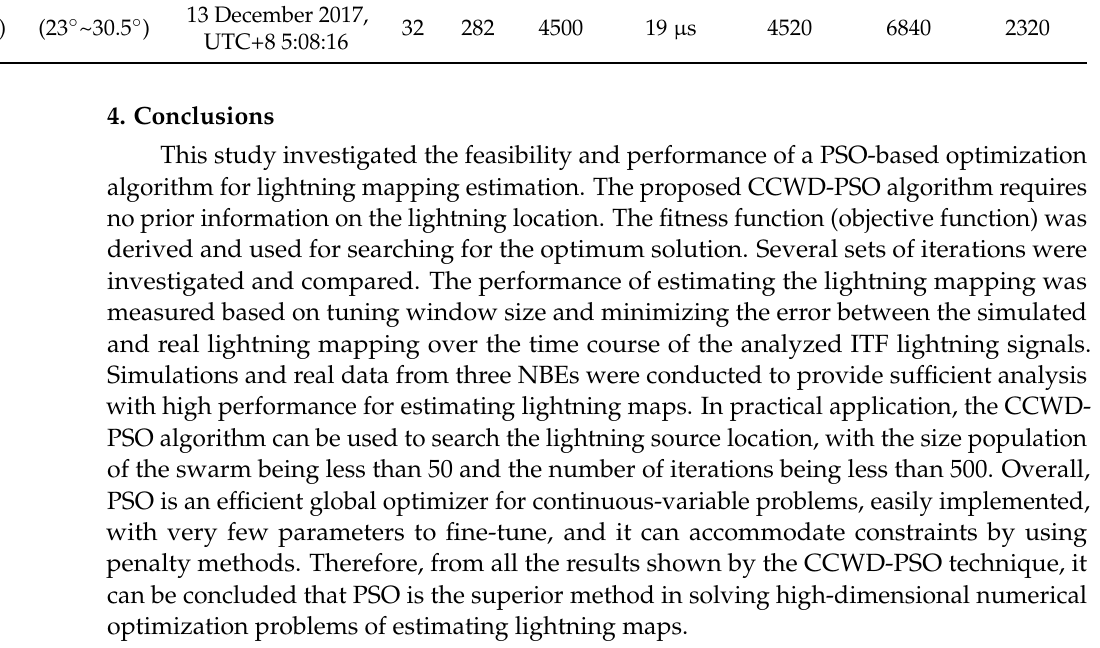
Higher NBE Altitude